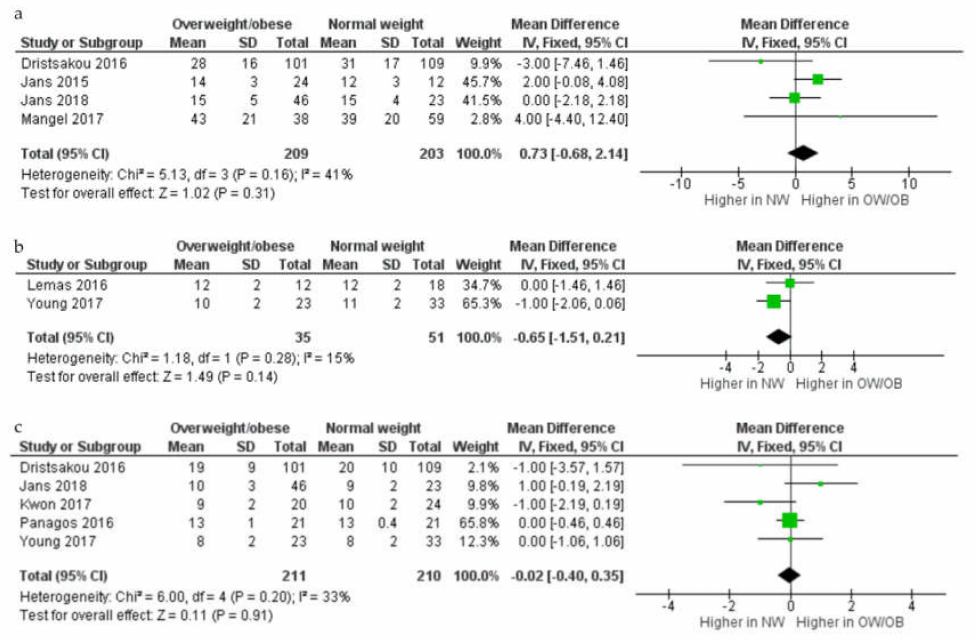
Figure 3. Comparison of protein concentration (g / L) from normal weight and overweight and obese women according to stage of lactation, colostrum ( a ), transitional ( b ), and mature ( c ). CI, confidence interval; Chi 2 and I 2 , measures of heterogeneity; IV, inverse variance; NW, normal weight women; OB, obese women; OW, overweight women; SD, standard